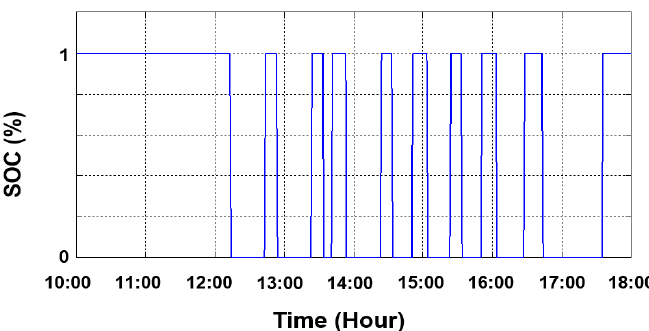
Energies 2023 , 16 , x FOR PEER REVIEW Figure 18. Fuzzy-based EMS in sunny day: grid relay. Figure 18. Fuzzy-based EMS in sunny day: grid relay. Figure 18. Fuzzy-based EMS in sunny day: grid relay.